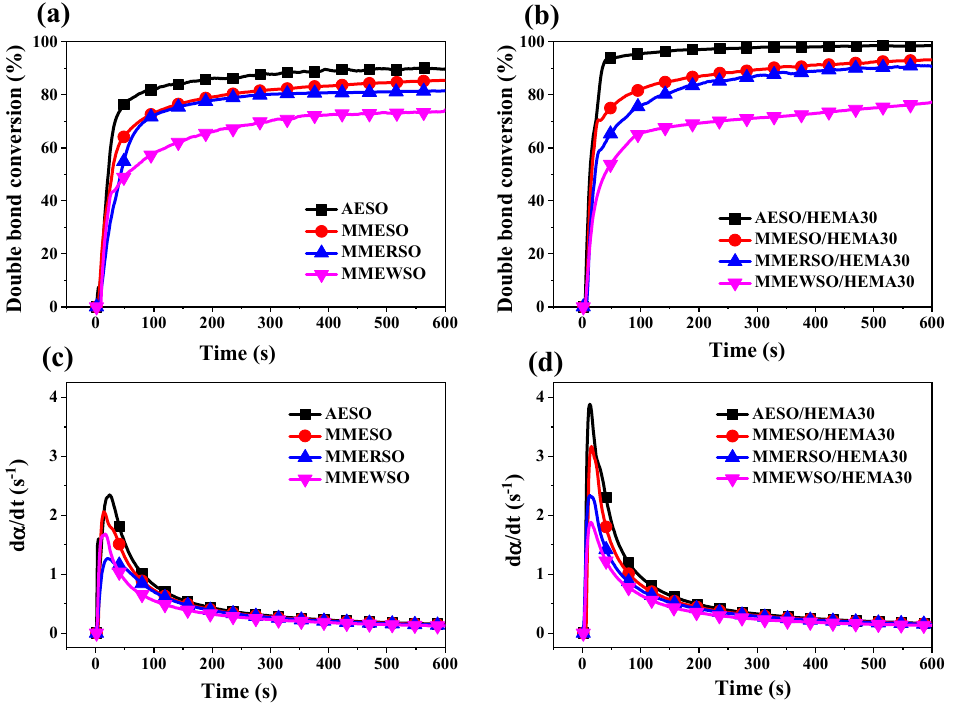
Figure 6. Double bonds conversion rates ( a,b ) and polymerization rates ( c,d ) of the UV-cured EA-like materials.